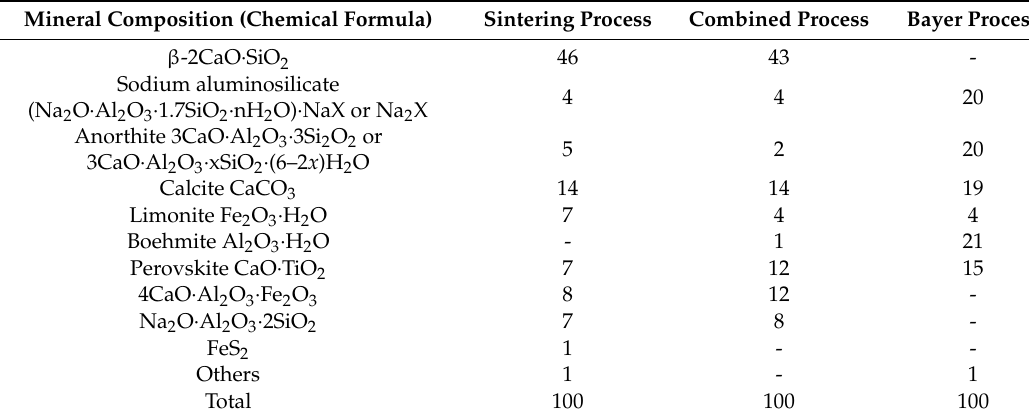
Table 2. Mineral composition of RM (%, ω ). Reproduced with permission from [23], published by Elsevier Ltd.,